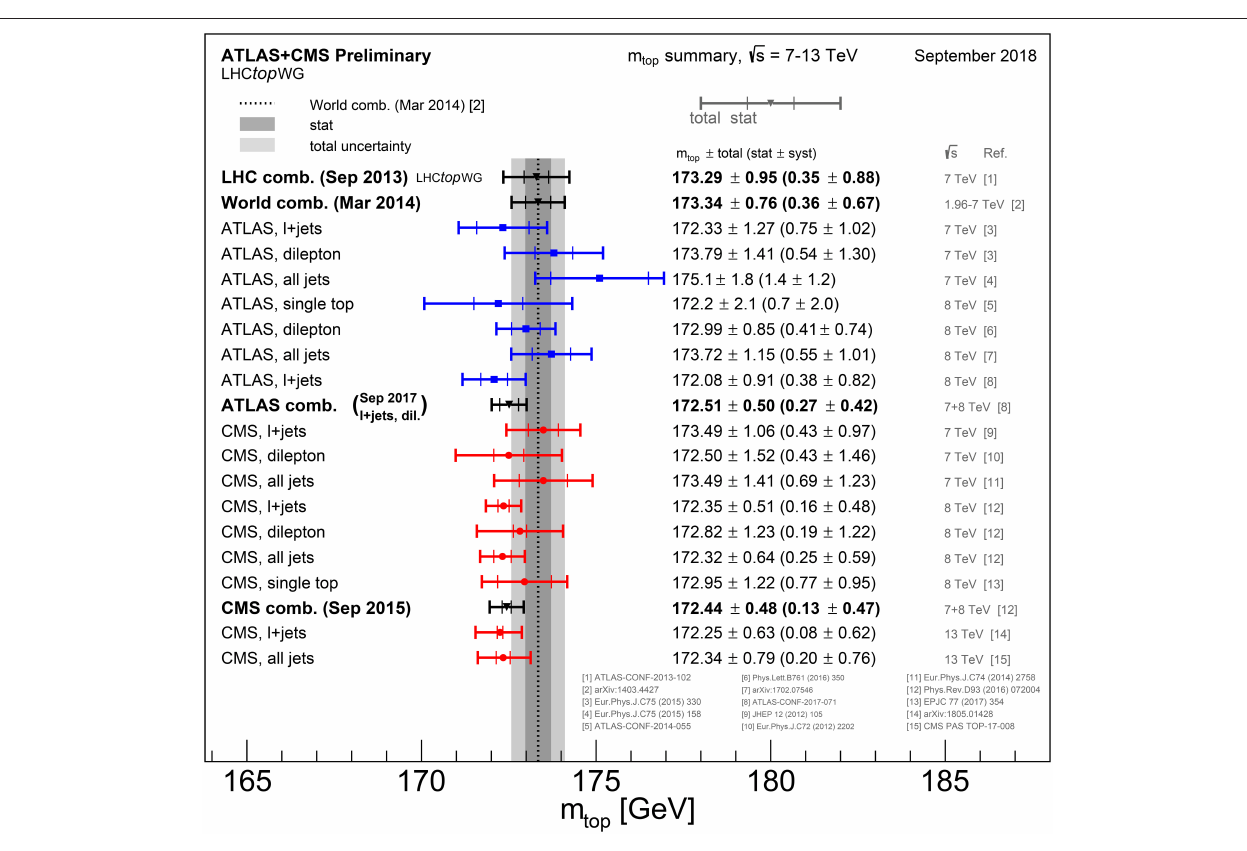
FIGURE 1 | Summary of the top-mass analyses at the LHC, accounting for the world average and the ATLAS and CMS combinations as